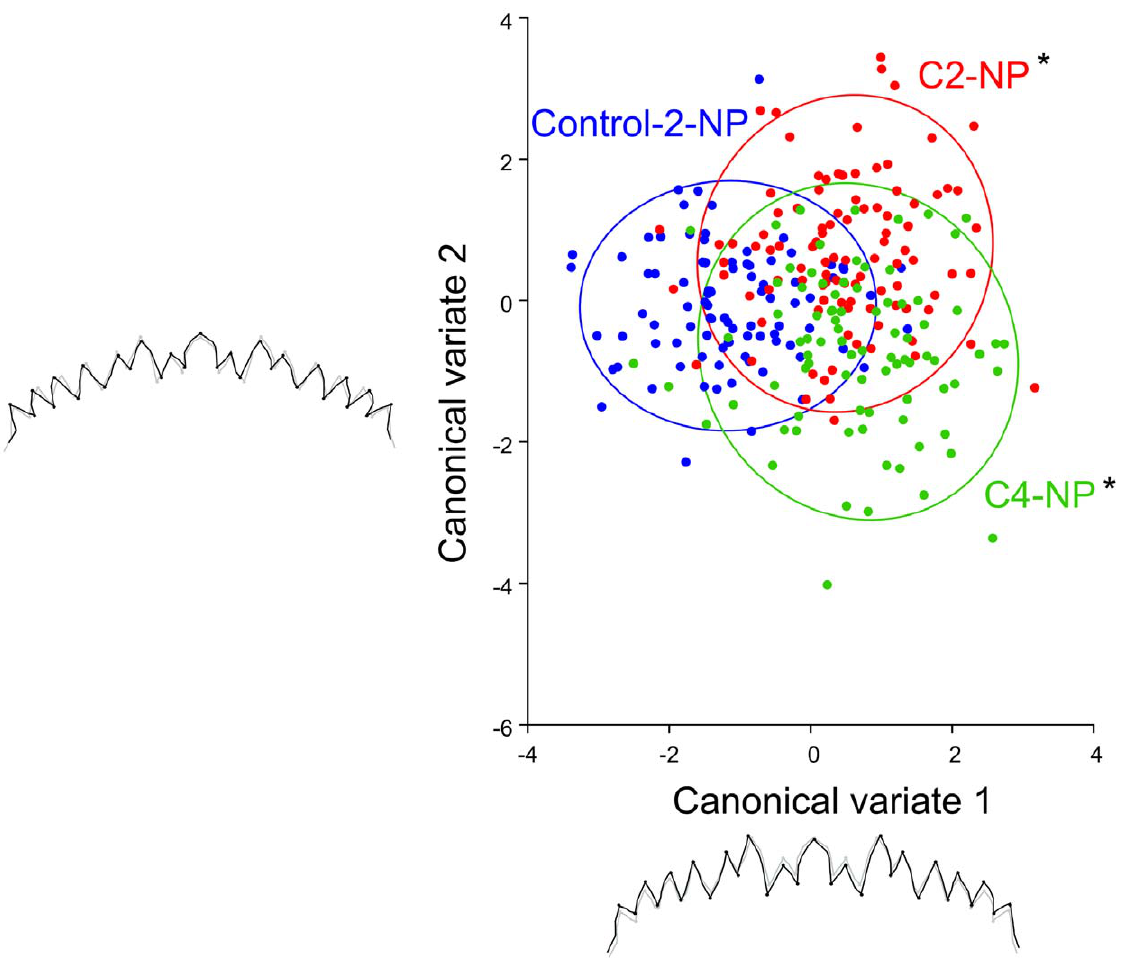
Figure 7. CVA showing the two discrimination vectors for the 2 d session of the 4-NP bioassay and the associated patterns of mentum variation. In grey extreme indivuals in negative side, in black extreme indivuals in positive side. *: Procuste distance significantly different from the control group (Permutation test, p , 0.05).